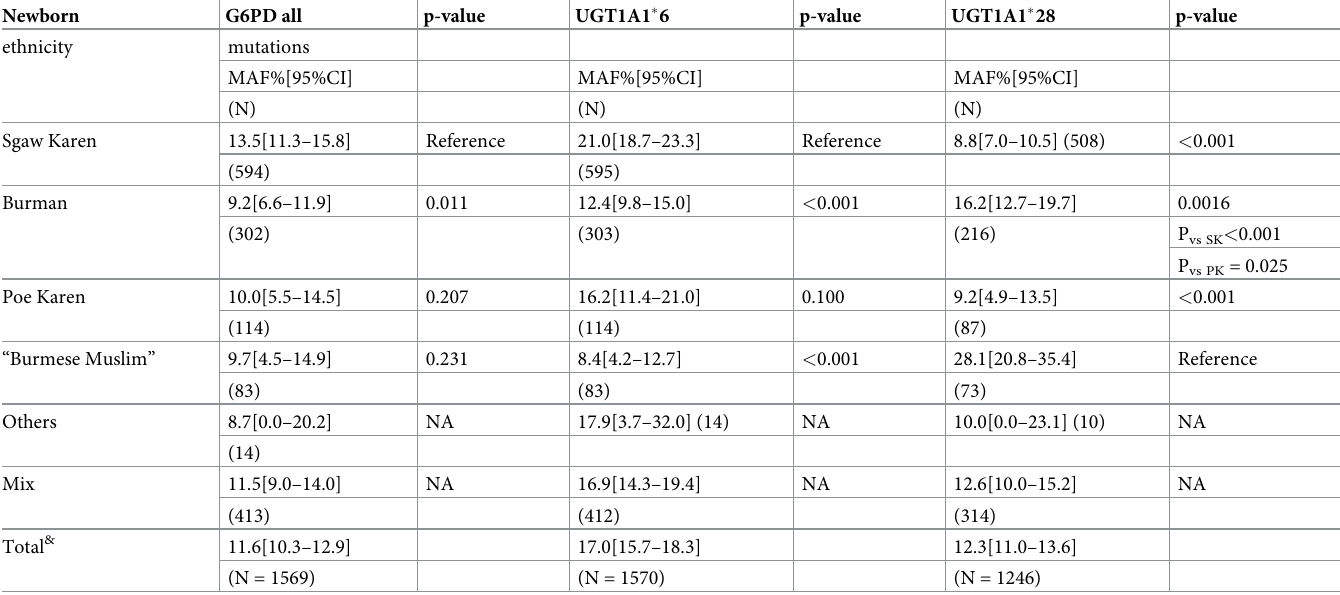
Table 1. Estimated allelic frequencies [95% confidence intervals] of genetic traits analysed in the cohort of